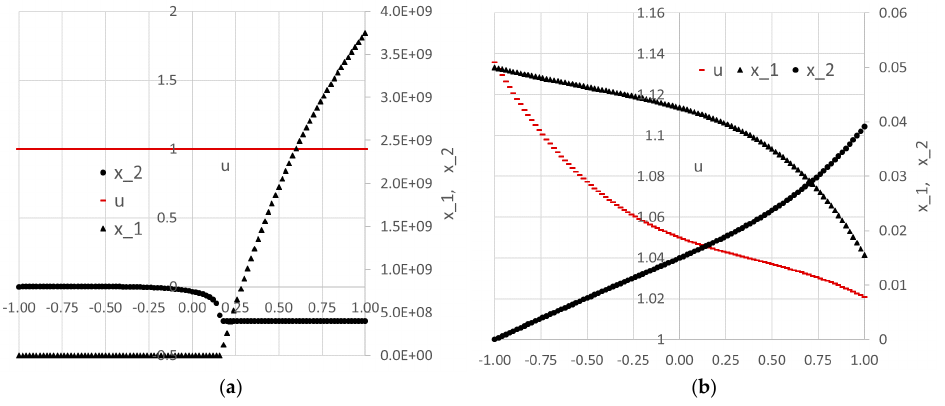
Figure 10. ( a ) Initial trajectories for optimal control problem (12)–(15) based on the default values shown in Figure 8; ( b ) Optimal trajectories found by Excel’s NLP Solver.